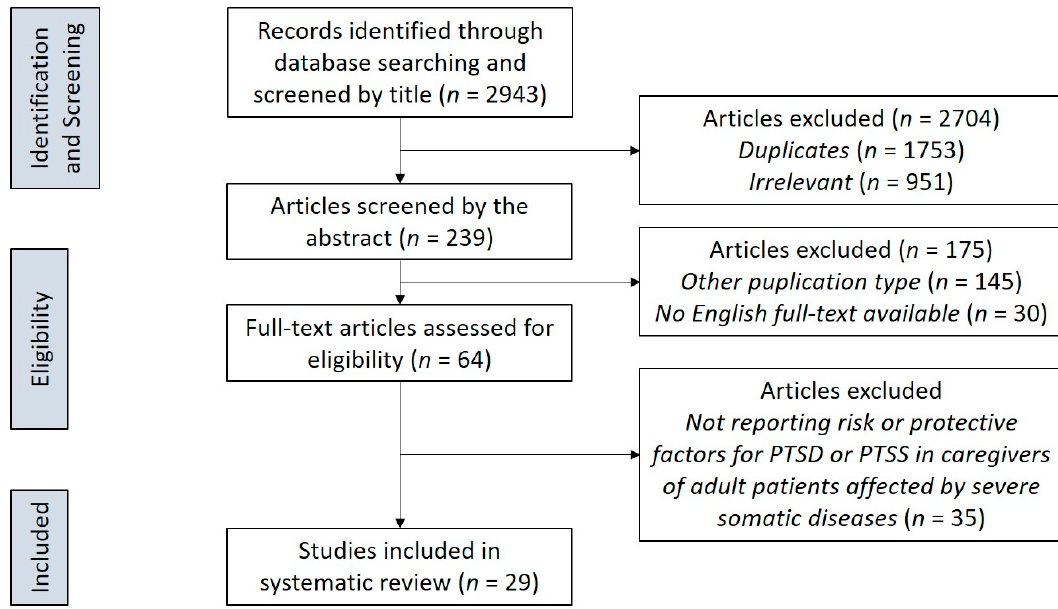
Figure 1. PRISMA flowchart of the study selection process. PRISMA, Preferred Reporting Items for Systematic reviews and Meta-Analyses; PTSD, Post-Traumatic Stress Disorder; PTSS, Post-Traumatic Stress Symptoms.